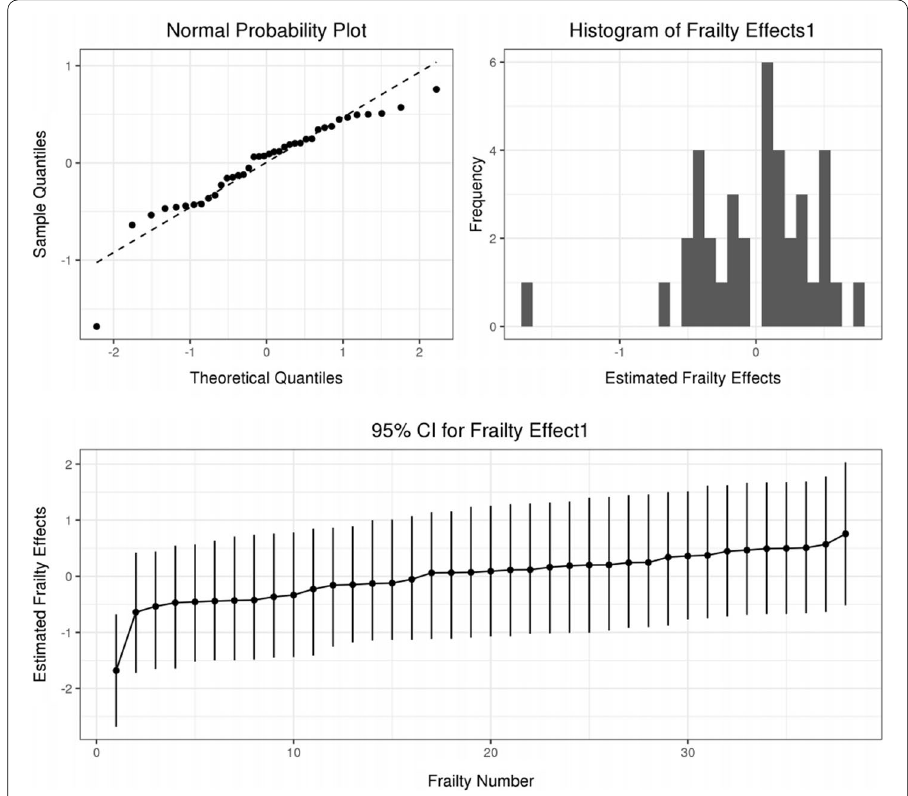
Fig. 9 Estimated frailty in the kidney infection